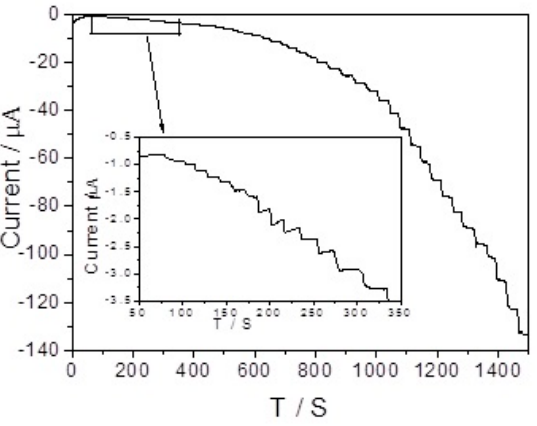
Figure 6. Amperometric response of the sensor for successive addition of H 2 O 2 in N 2 -saturated 0.1 M PBS (pH = 7.4) solution. The applied potential is − 0.5 V, (inset: a partial magnification of the current response toward a low concentration of H 2 O 2 solution).